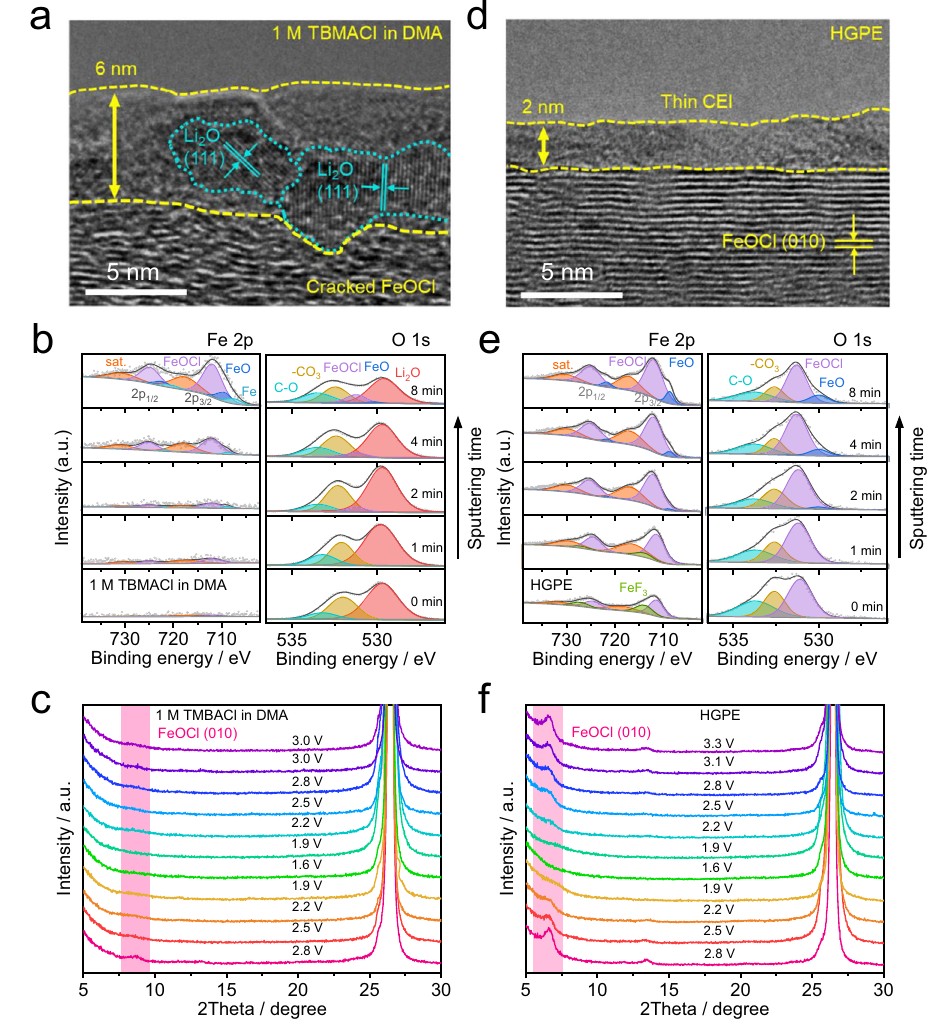
Fig. 4 | Ex situ physicochemical characterizations of the FeOCl-based electro- des. a TEM images of FeOCl electrodes sampled from Li||FeOCl coin cells with 1M TBMAClinDMAelectrolyteafter3cyclesat125mAg − 1 and25°C. b Exsituin-depth Fe 2 p and O 1 s XPS spectra of FeOCl cathodes in 1M TBMACl in DMA electrolyte. c Ex situ XRD patterns of FeOCl-based electrodes cycled in Li metal coin cells with